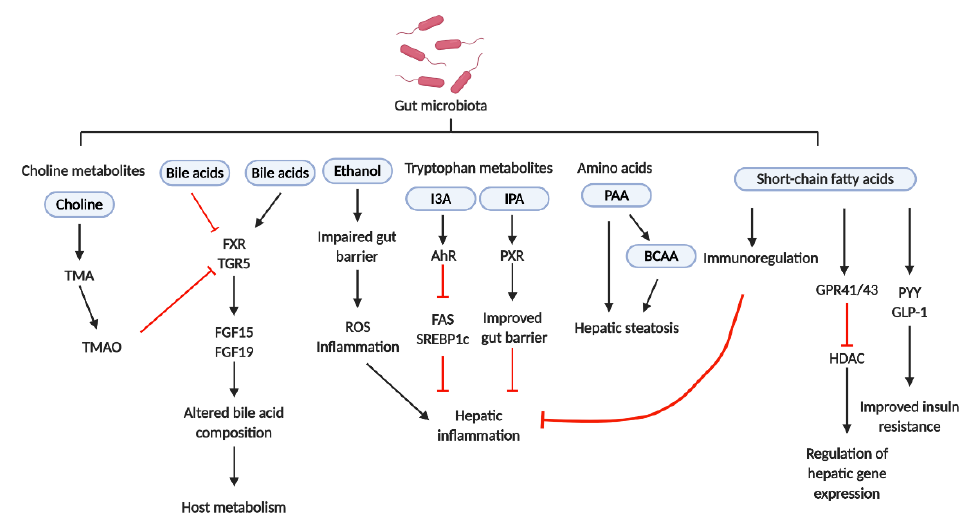
Figure 4. The roles of gut microbiota-derived metabolites. Short-chain fatty acids (SCFAs) are associated with the release of PYY and GLP-1, which further ameliorate insulin resistance. SCFAs also activate GPR41 / 43, performing the regulation of hepatic gene expression via inhibition of HDAC. Additionally, SCFAs also perform immunoregulation to inhibit hepatic inflammation. PAA can induce hepatic steatosis by itself or via a ff ecting BCAA metabolism. IPA improves intestinal barrier function via PXR, which improves tissue inflammation. I3A reduces hepatic FAS and SREBP1 expression via AhR, further reducing hepatic inflammation. Increasing endogenous ethanol production may deteriorate hepatic inflammation. Specific BAs act as agonists or antagonists of FXR and TGR5 which a ff ect the composition of BAs and further a ff ect host metabolism. TMAO, which is derived from TMA and choline, modulates BA metabolism and FXR signaling inhibition, contributing to NAFLD pathogenesis. TMA, trimethylamine; TMAO, trimethylamine-N-oxide; FXR, farnesoid X receptor; TGR5, Takeda G protein-coupled bile acid receptor 5; FGF, fibroblast growth factor; I3A, indole-3-aldehyde; IPA, indole-3-propionic acid; AhR, aryl-hydrocarbon receptor; PXR, pregnane X receptor; FAS, fatty acid synthase; SREBP1c, sterol regulatory element-binding protein-1c; PAA, phenylacetic acid; BCAAs, branched-chain amino acids; GPR, G-protein coupled receptor; GLP-1, glucagon-like peptide-1; PYY, peptide-YY; HDAC, histone deacetylase.